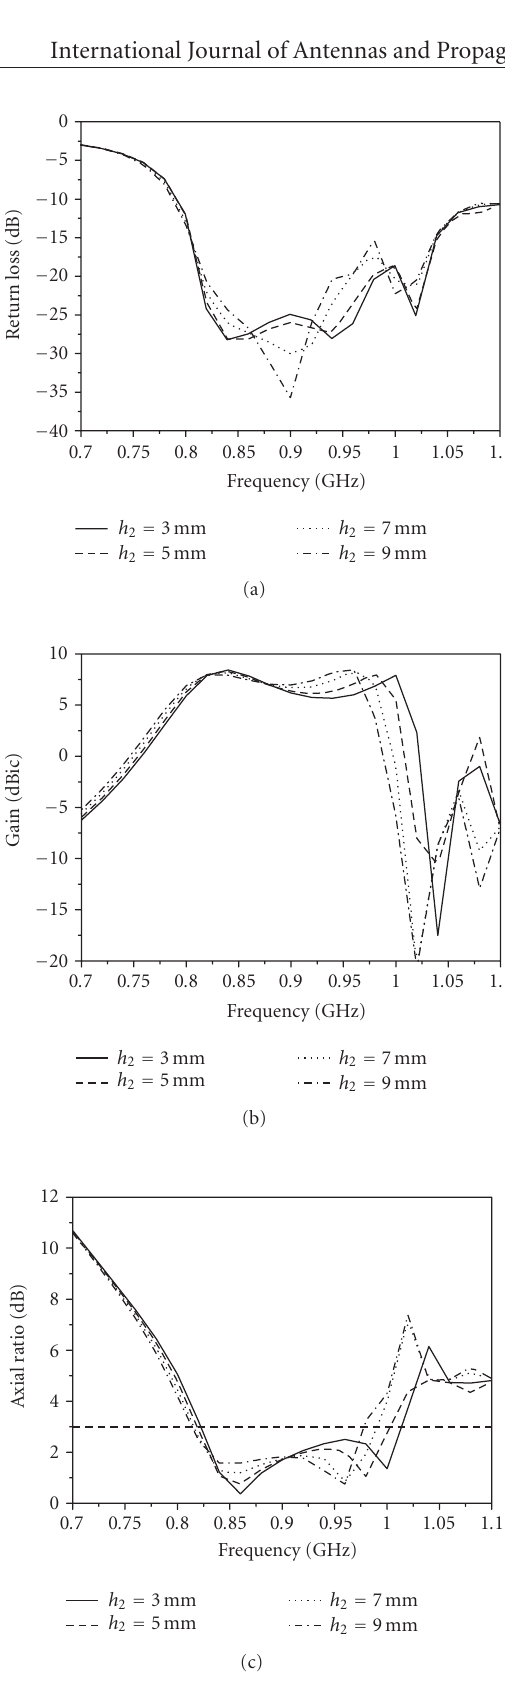
Figure 9: E ff ect of the height of the primary patch on the perfor- mance of the proposed antenna: (a) return loss; (b) gain; (c) axial ratio.